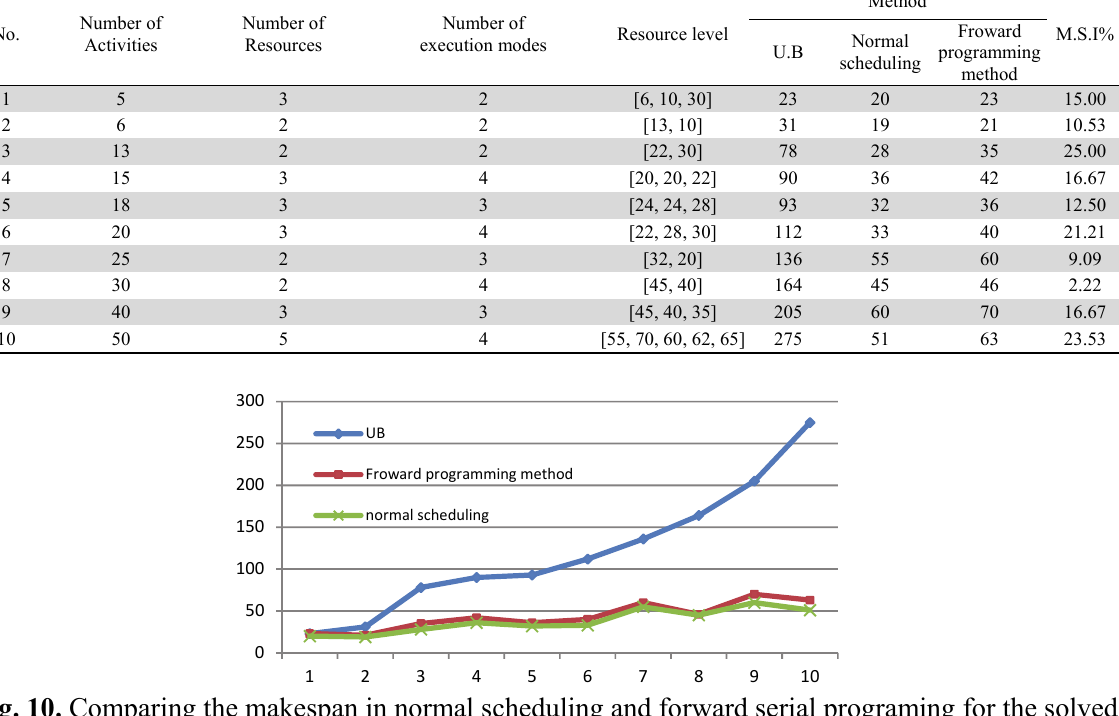
Results gained after scheduling experiments